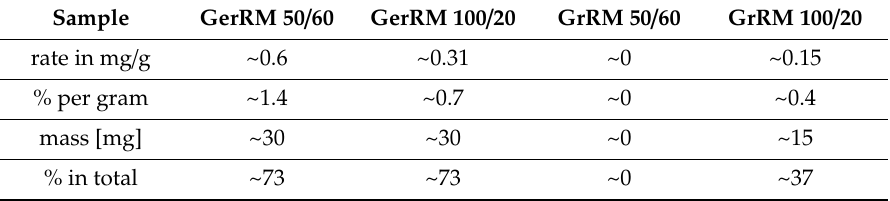
Table 7. Adsorption kinetics of manganese by red mud with the percentage at assumed equilibrium.